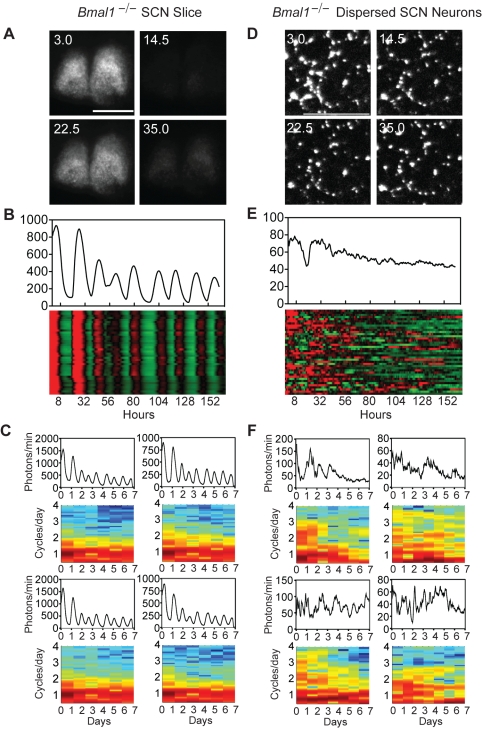
Stochastic rhythmicity in Bmal1
−/− SCN is not cell autonomous.(A) Bioluminescence images of a Bmal1
−/− SCN explant culture at peak and trough phases. Numbers indicate hours after start of imaging. Scale bar = 500 µm. Imaging experiments were initiated after 2–3 wk of culture. (B) Average bioluminescence and heatmap plots of bioluminescence intensity of individual Bmal1
−/− neurons in an intact organotypic SCN slice. Forty cells are presented, with each horizontal line representing a single cell. These cells show tightly synchronized stochastic rhythms that are comparable to rhythms seen with PMT luminometry. (C) PER2::LUC rhythms (top) and corresponding FFT Spectrograms (bottom) for first 4 cells shown in (B) (i.e., coupled in Bmal1
−/− SCN explant). (D) Bioluminescence images of dissociated individual Bmal1
−/− SCN neurons showing nonrhythmic bioluminescence patterns. Numbers and scale bar are as in (A). (E) Average bioluminescence and heatmap plots of bioluminescence intensity of 40 individual Bmal1
−/− neurons in dispersed culture imaged in (D), showing a lack of co-ordinated rhythmicity. (F) PER2::LUC rhythms (top) and corresponding FFT spectrograms (bottom) for first 4 cells shown in (E) (i.e., dispersed Bmal1
−/− SCN cells).